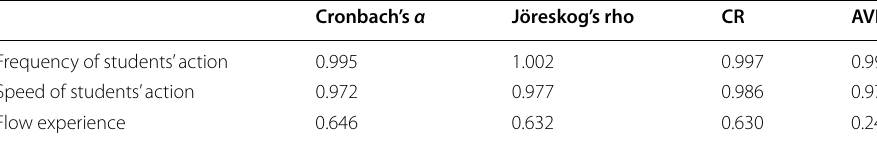
CR composite reliability, AVE average variance extracted